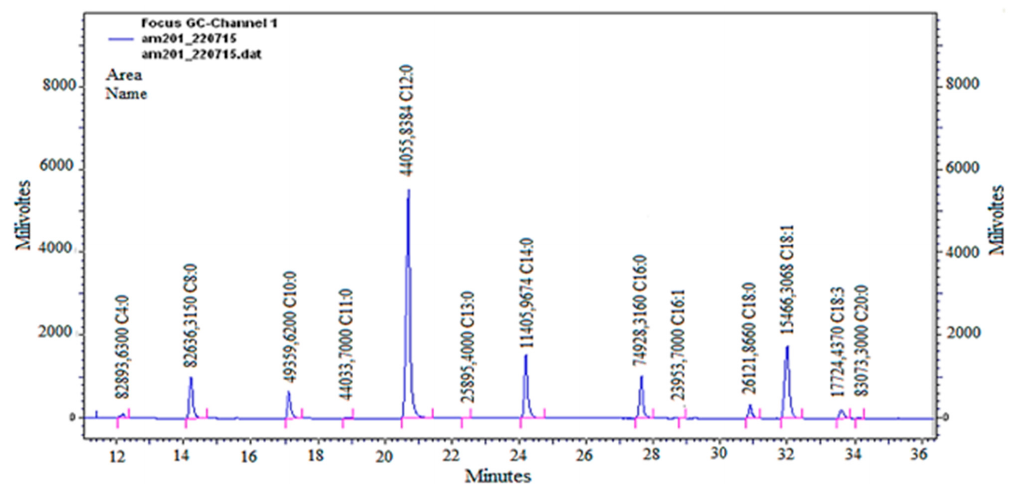
Figure 1. General chromatogram from the analysis of fixed almond oil from A. heterophyllus by GC-FID.